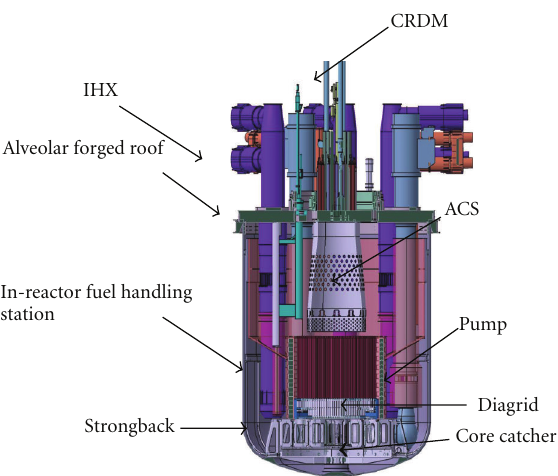
Figure 2: Preconceptual design for SFR reactor block.